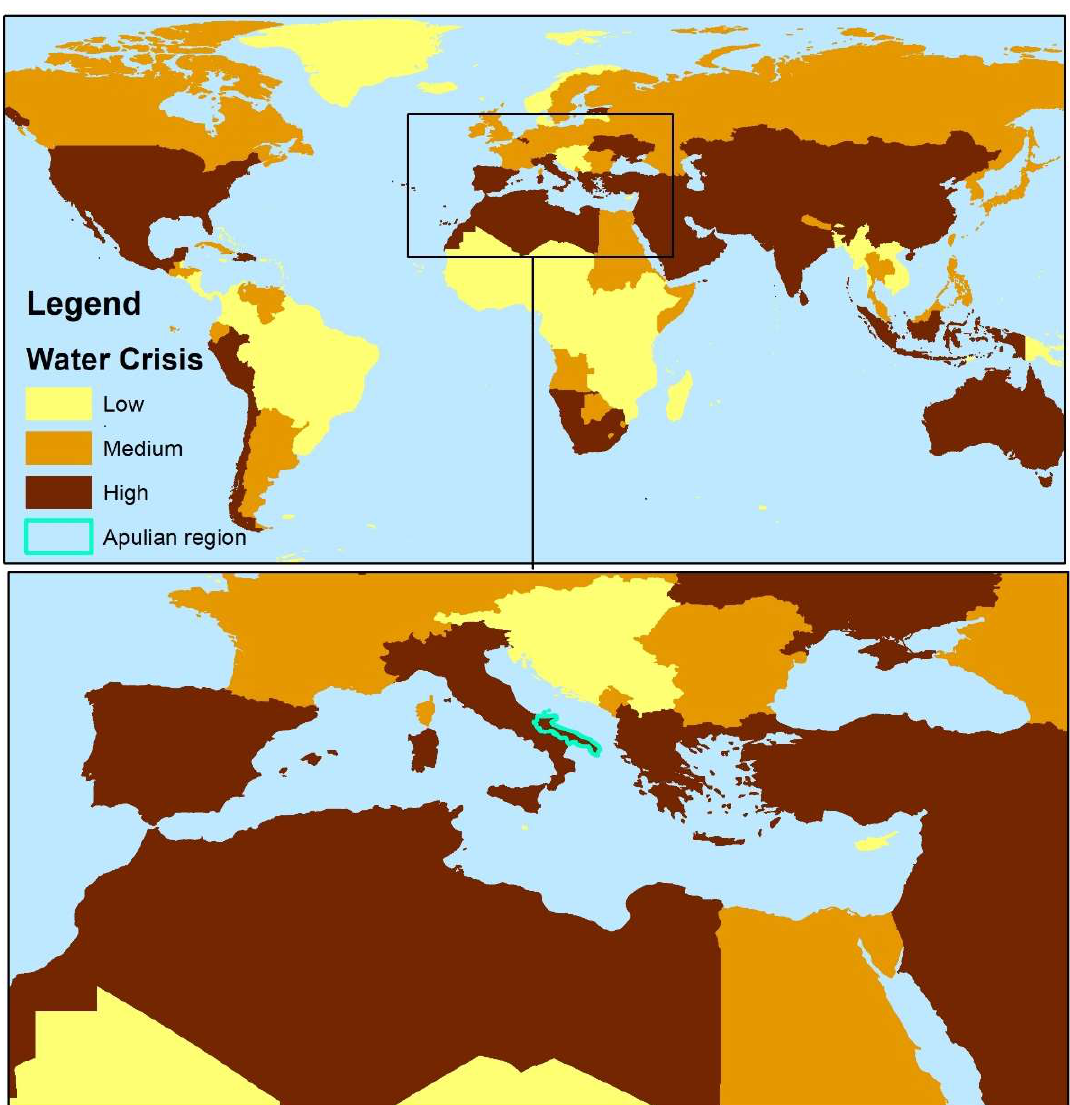
Figure 2. The world spatial analysis of the water crisis in future years. Data sources from [66].